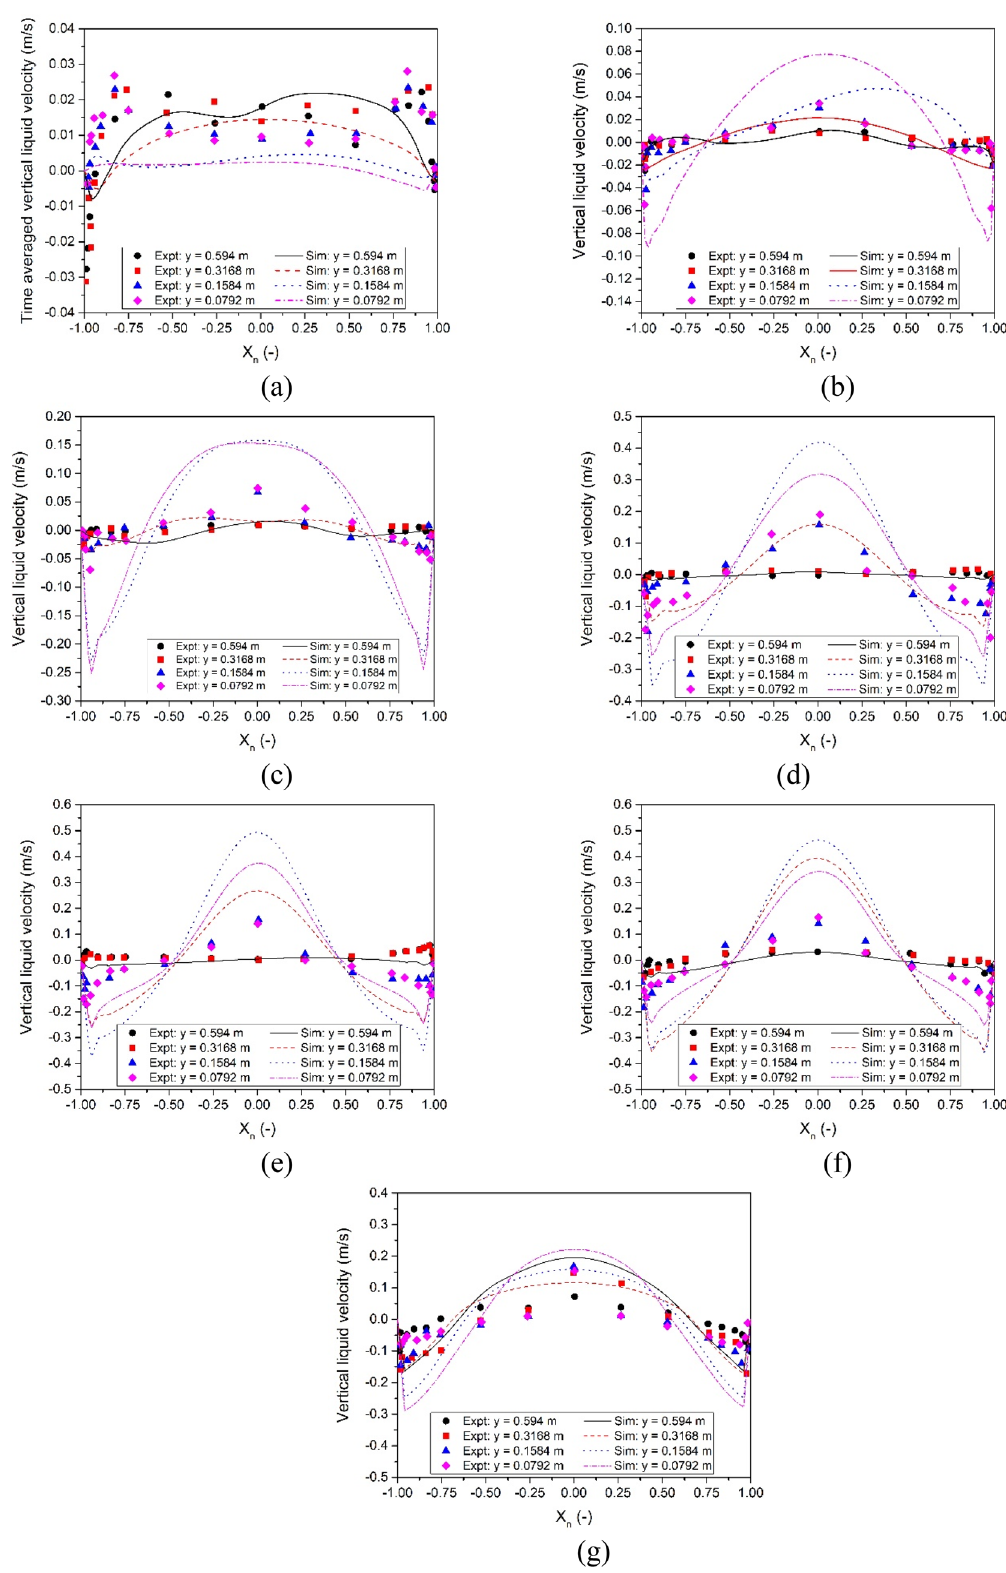
Fig. 8 Effect of sparger type on time-averaged vertical liquid velocity a A1 (100%), b A2 (95%), c A3 (85%), d A4 (69%), e A5 (59%), f A6 (44%) and g A7 (18%) (U = 2.9 G